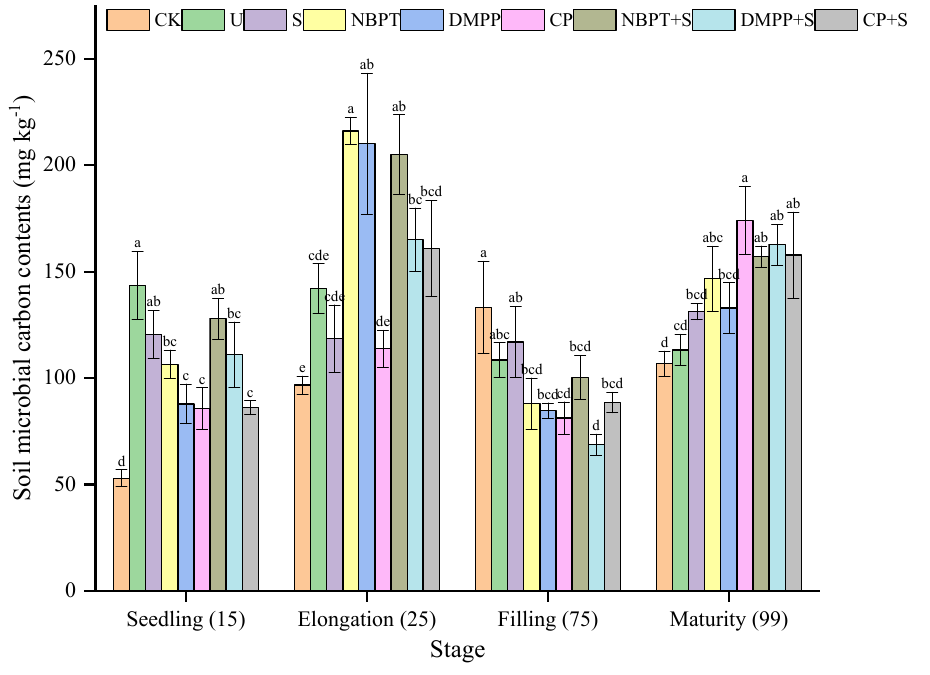
Figure 5. Soil microbial carbon (MBC) contents of different treatments. Different letters indicate significant differences between different treatments at p < 0.05 by Tukey test.